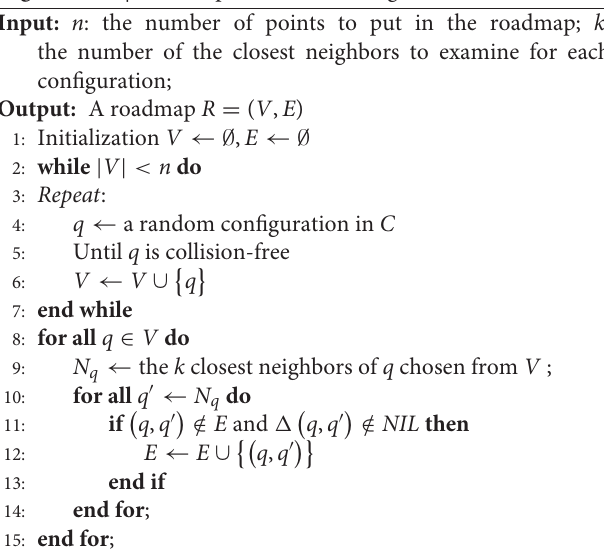
Algorithm 1 | Roadmap Construction